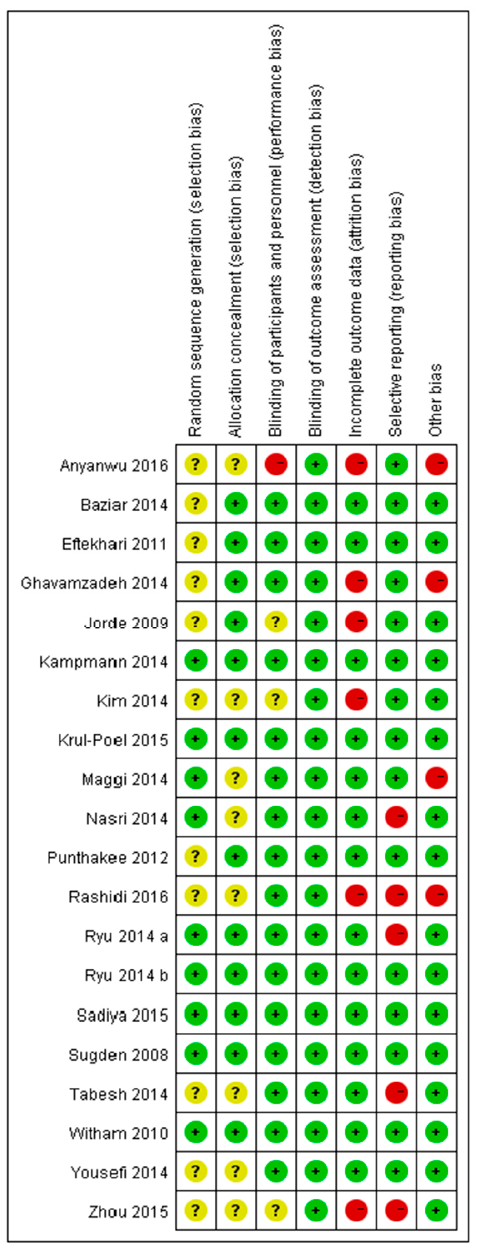
Figure 2. Risk of bias assessment of the included studies using the Cochrane Collaboration tool across seven domains. Risk of bias levels: low (green), unclear (yellow), high (red).